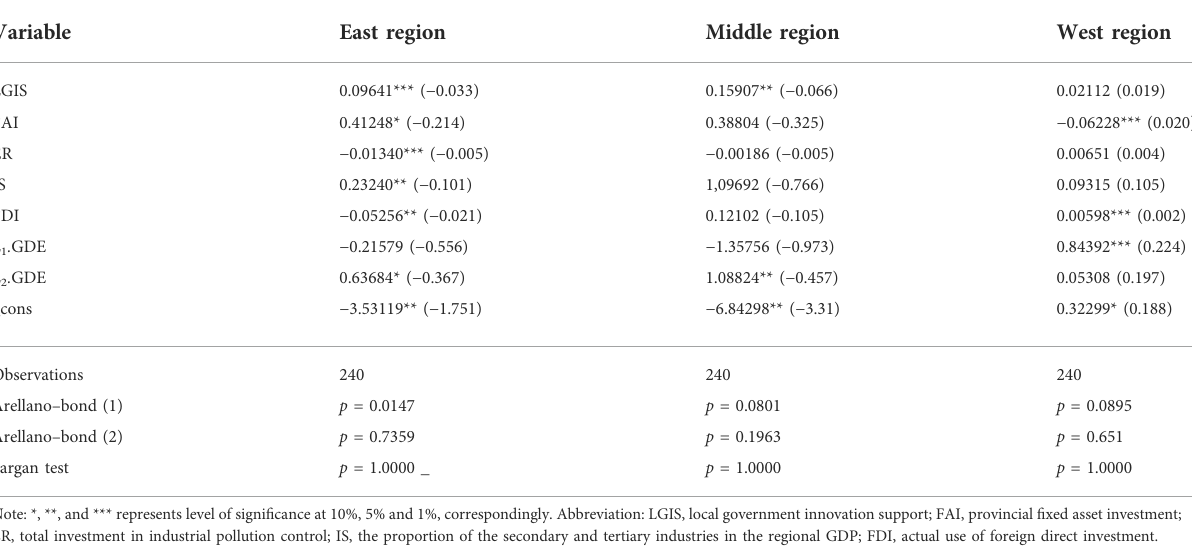
TABLE 7 Sub-regional test results: dynamic panel system GMM model.